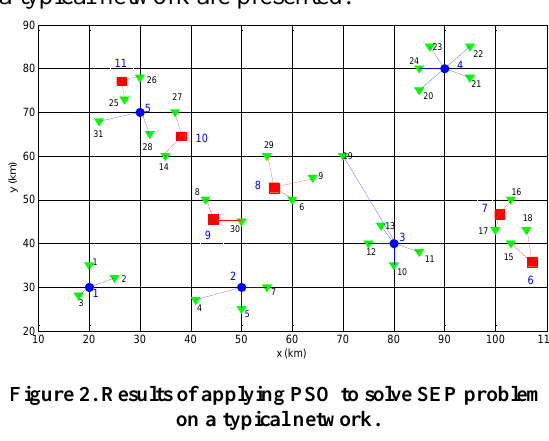
Figure 2. Results of applying PSO to solve SEP problem on a typical network.